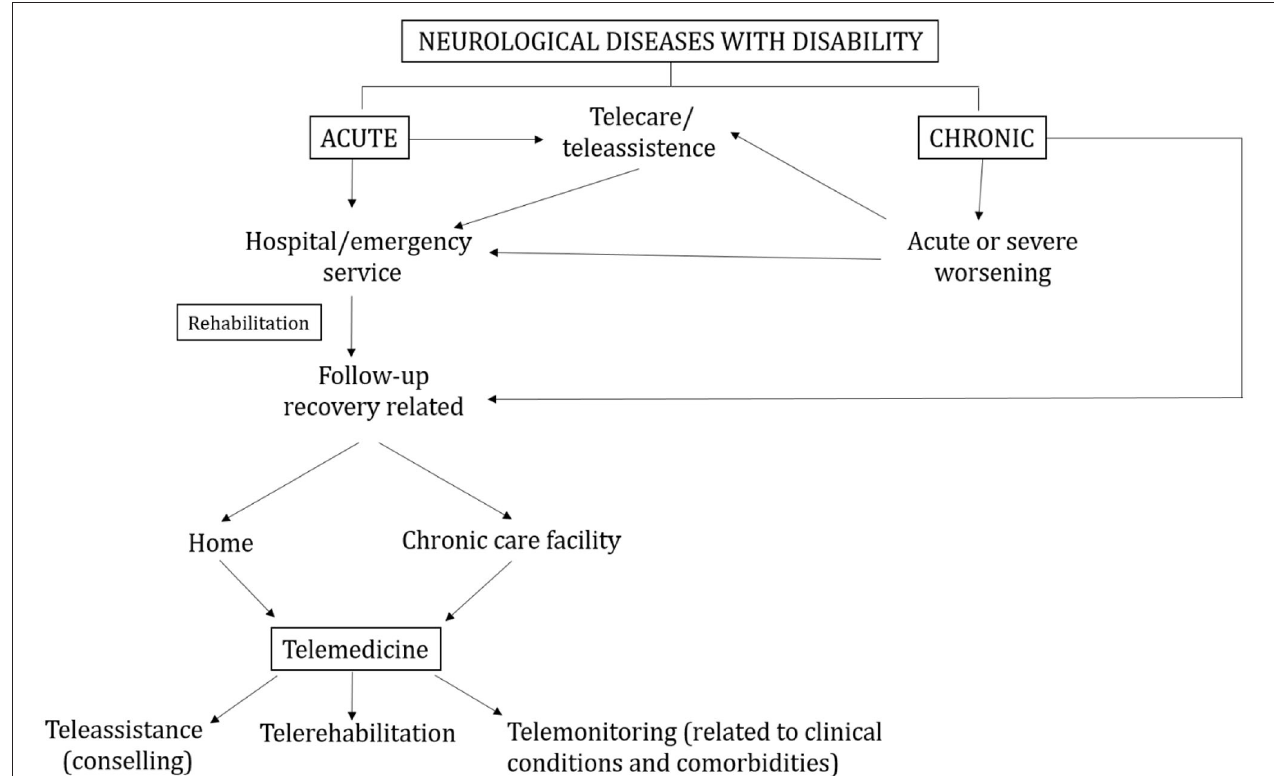
FIGURE 1 | Flow chart of the clinical and telemedicine pathways in patients with acute or chronic neurological diseases.